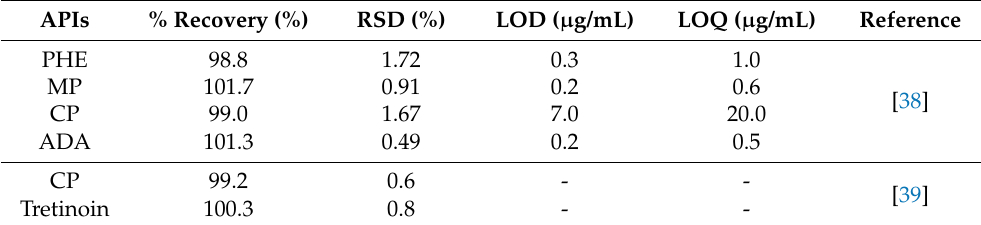
Table 4. A comparative assay of results of the present study with the reported studies.